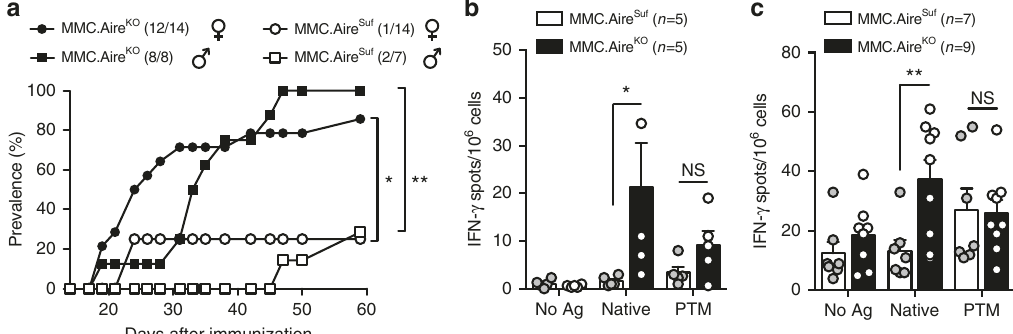
Fig. 2 Tolerance to the non-modi fi ed CII 260 – 270 epitope is lost after Aire de fi ciency. Loss of tolerance to CII occurs in an Aire-dependent way and speci fi cally affects T cells speci fi c for the non-modi fi ed CII 260 – 270 epitope. a Arthritis prevalence in MMC.Aire Suf and MMC.Aire KO male and female mice after immunization with rat CII. b , c ELISPOT data from in vitro recall responses of pooled lymph node and spleen cells from indicated number of MMC. Aire Suf and MMC.Aire KO mice 10 days ( b ) or 10 weeks ( c ) after CII immunization. Cells were stimulated with the non-modi fi ed and PTM CII 260 – 270 peptide or left unstimulated (No Ag). Values shown are the mean ± SEM number of spots recorded for IFN- γ producing cells. Fisher ′ s exact test was used to calculate signi fi cance of arthritis prevalence, whereas Mann – Whitney U test was used in ELISPOT assays. * p < 0.05; ** p < 0.01; NS not signi fi